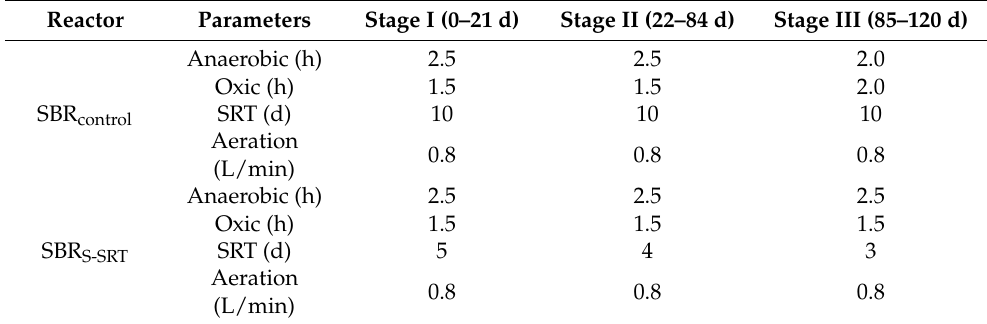
Table 2. Operation strategies of the two experimental